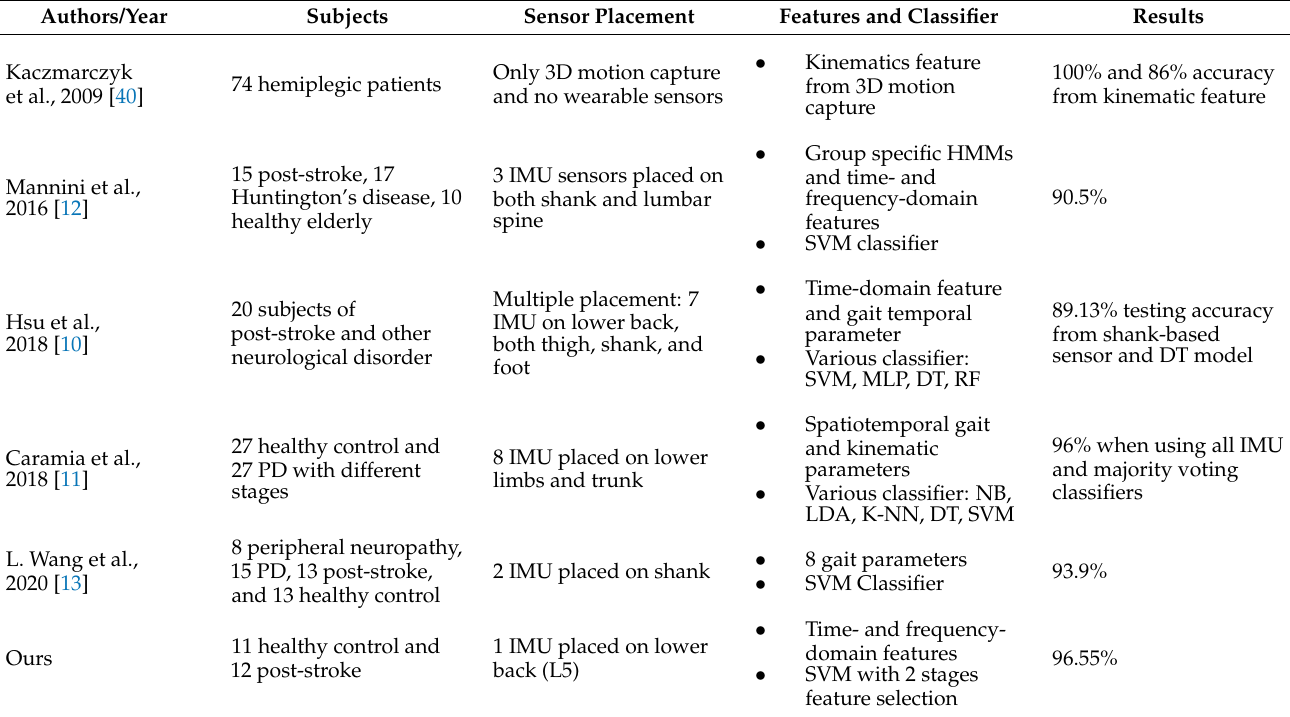
Table 4. Comparison of method and results with other